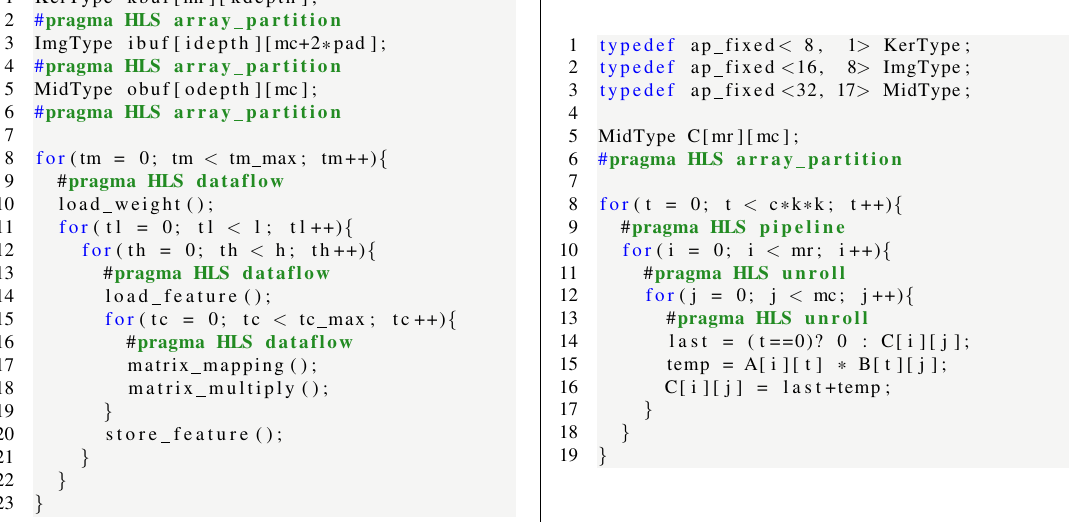
Figure 6. High level synthesis (HLS) pseudocode demonstrating the working process of a convolutional layer ( left ) and how to compute the matrix multiplication with the 2D MAC array ( right